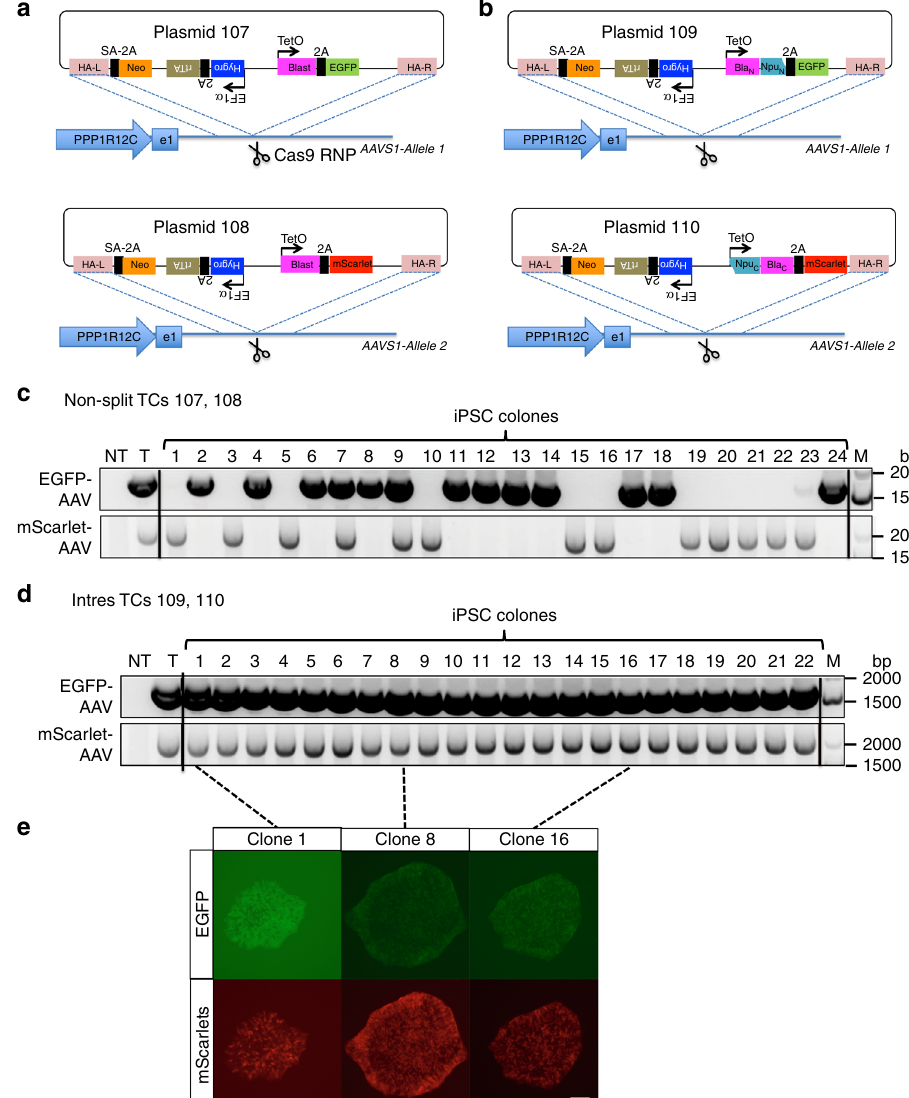
Fig. 5 Intres for selection of biallelic CRISPR knock-in in human induced pluripotent stem cells. a Plasmids 107 and 108 contain AAVS homology arms, and Dox-inducible full-length (FL) Blasticidin (Blast) and EGFP (plasmid 107) or mScarlet (plasmid 108) separated by a self-cleaving 2 A peptide sequence. b Plasmids 109 and 110 contain AAVS homology arms, and Dox-inducible N-split Blast markertron and EGFP (plasmid 109) or C-split Blast markertron and mScarlet (plasmid 110) separated by a self-cleaving 2A peptide sequence. Cas9 ribonucleoprotein was formed in vitro by complexing puri fi ed Cas9 proteins with synthetic sgRNA targeting AAVS locus, introduced to hiPSCs together with targeting constructs by nucleofection, subsequently subjected to dox-induction and antibiotic selection, and fi nally cloned by colony picking and analyzed for allelic modi fi cation. c Genotyping PCR for EGFP- and mScarlet- inserted AAVS alleles of single iPSC clones generated by CRISPR editing using non-split targeting constructs (TCs) 107 and 108. NT: Non-targeted; T: Targeted pool; M: Marker = GeneRuler 1 kb + ladder. d Genotyping PCR for EGFP- and mScarlet-inserted AAVS alleles of single iPSC clones generated by CRISPR editing using Intres TCs 109 and 110. NT: Non-targeted; T: Targeted pool; M: Marker = GeneRuler 1 kb + ladder. e Representative fl uorescent microscopic images of hiPSC colonies from the indicated clones derived from the Intres CRISPR experiments using TCs 109 and 110. Scale bar: 200 μ Puri fi ed Cas9 proteins were complexed with synthetic sgRNA to form Cas9 ribonucleoprotein (RNP) and co-nucleofected with the targeting constructs into KOLF2-C1, followed by dox-induction and antibiotic selection. Surviving colonies were picked into separate wells for establishing single-cell clones. Genotyping PCR revealed that targeting using non-split Blast resistance gene generated only 8% biallelic clones, while targeting using Blas- ticidin Intres yielded exclusively (100%) biallelically modi fi ed clones (Fig. 5c, d), showing both fl uorescent signals (Fig. 5e) indicative of the targeting by each targeting construct at the two alleles of AAVS in these hiPSCs.